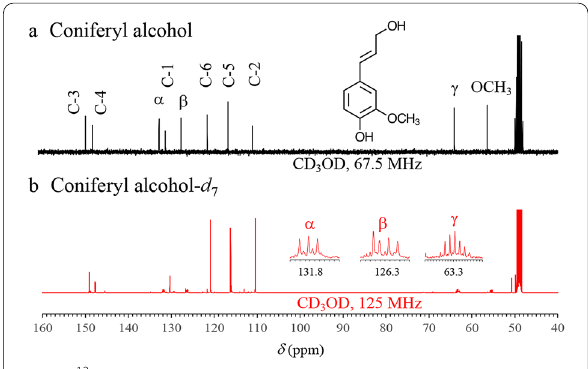
Fig. 2 13 C NMR spectra of coniferyl